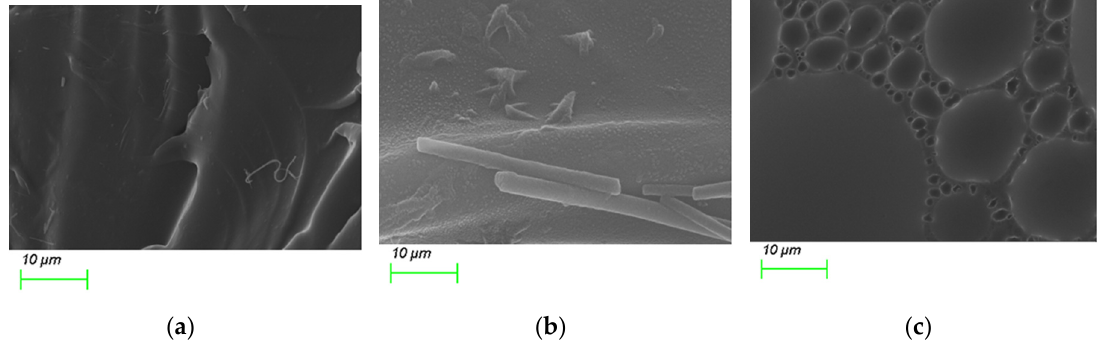
Figure 3. SEM images of PS@C6^PtP membranes with GOD immobilized onto ( a ) EC, ( b ) D4, and ( c ) GA.